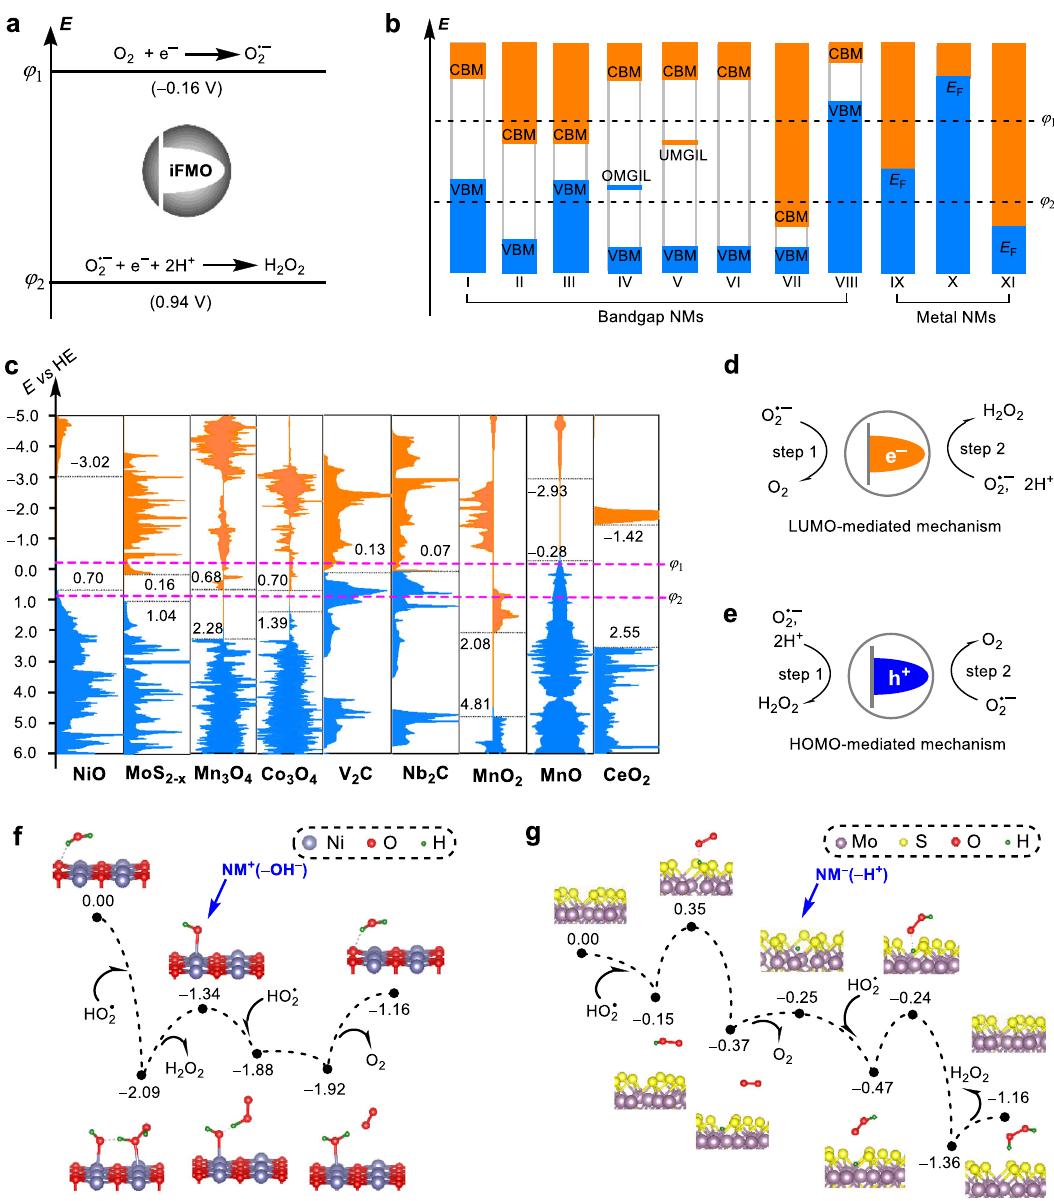
Fig. 2 The energy level principle for NMs to catalytically scavenge O 2 (cid:129) − . a The model for nanomaterials, where intermediate frontier molecular orbital (iFMO) means the FMO with energy located in the range ( φ 1 , φ 2 ). b Nanomaterials having different types of FMOs with respect to the potentials φ φ 1 and 2 . c Calculated electronic density of states with the energies of FMOs marked. ( d , e ) Diagrams for the LUMO- and HOMO-mediated catalytic mechanisms. ( f , g ) Reaction energy pro fi les corresponding to the superoxide dismutase-like catalyzes of NiO(100) and MoS 2 − x , respectively; the intermediates with the ionic nature are labeled. In ( f , g ) some water molecules as explicit solvents and the kinetically unfavorable pathways are not shown for clarity; the complete energy pro fi les are given in Supplementary Fig. 1. In b – d , and e , the blue and orange colors represent the occupied and unoccupied molecular orbitals,